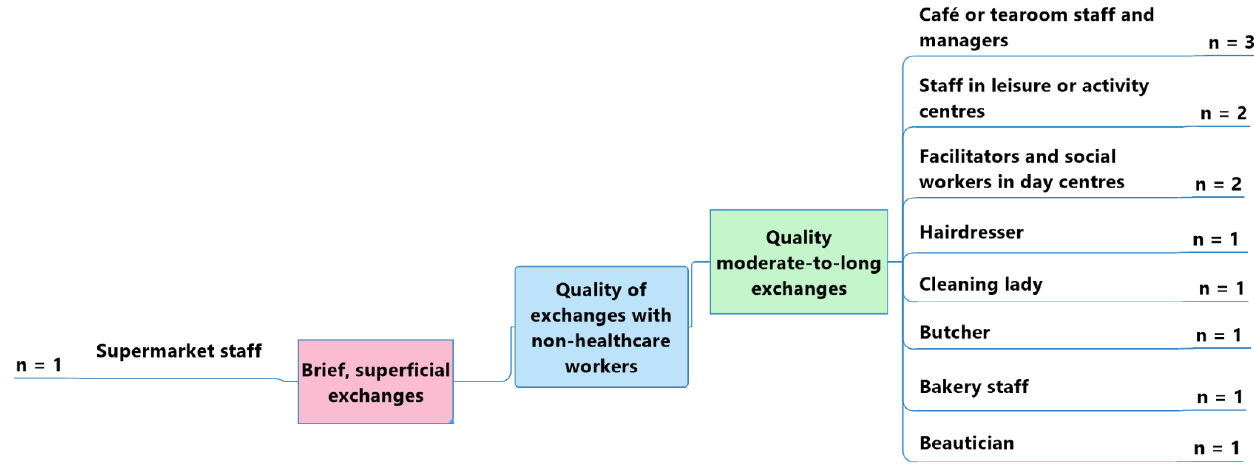
Figure 6. Perceived quality of the exchanges between participants with a probable or diagnosed slight cognitive impairment or mild-to-moderate dementia and non-healthcare workers.